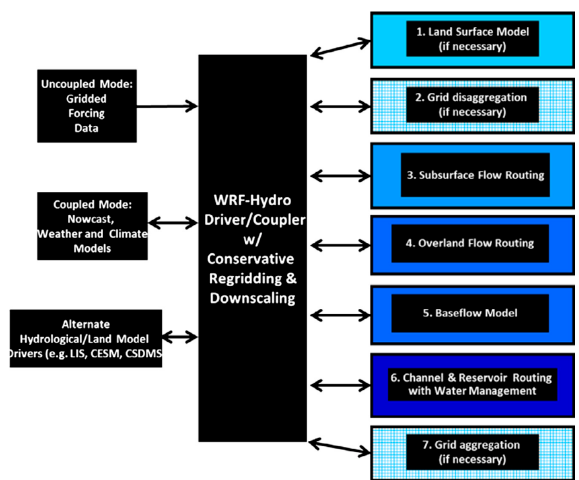
Figure 2. Schematic of the WRF-Hydro architecture showing the various model components (see Gochis et al. [22] for technical details). Table 1. Namelist of physics options